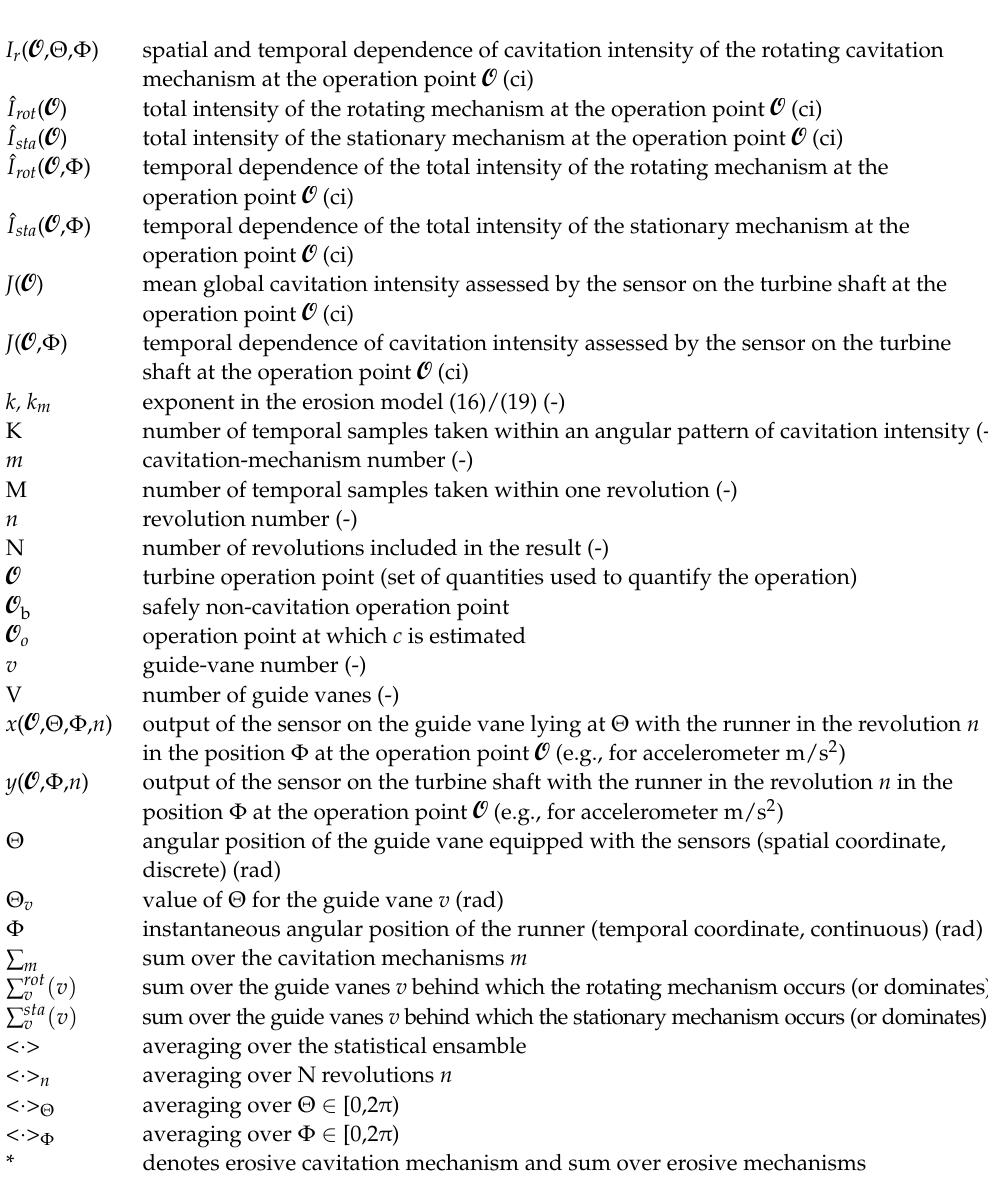
Figure 3. Front panel of the multidimensional data acquisition processor. The simplest description of cavitation comes out online after half an hour of measurement on the prototype. More compli- cated descriptions require days or weeks of recorded data analysis by a trained user.